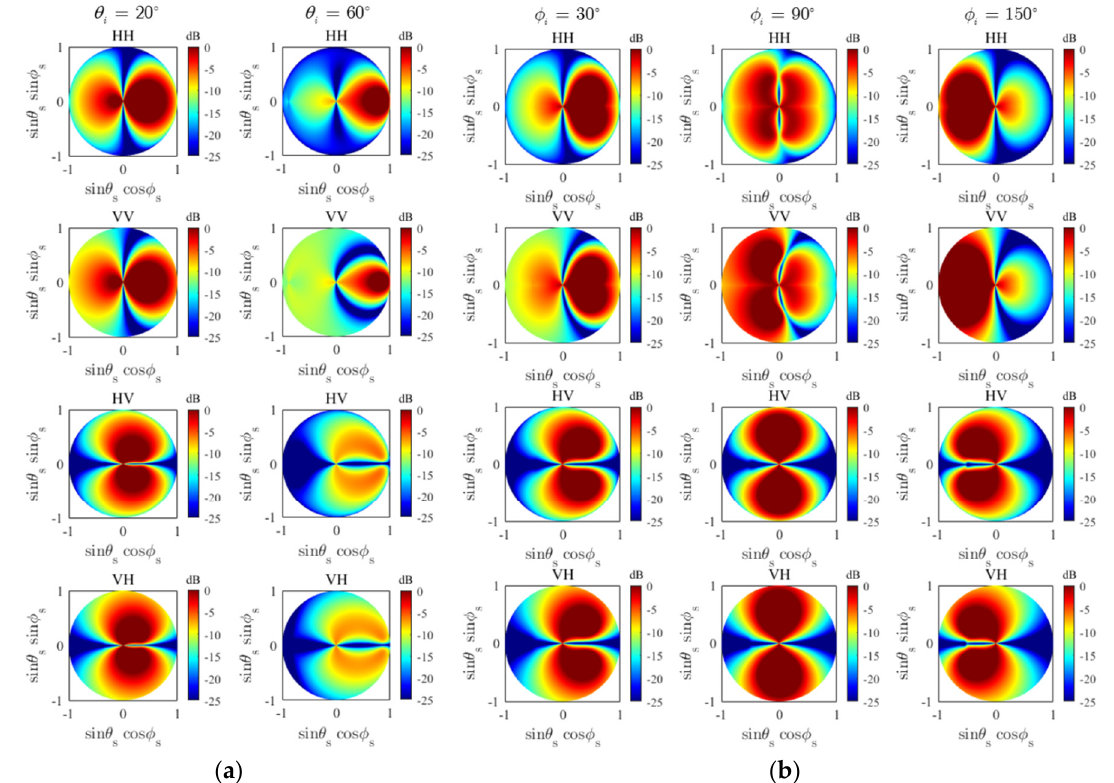
Figure 2. Hemispherical plots of bistatic scattering coefficients σ 0 , σ 0 , σ 0 , σ 0 vv with f = 5.3 GHz, U = 25 m/s, φ w = 30 ◦ : hh hv vh ( a ) φ i = 0 ◦ for all subplots; θ i = 20 ◦ for subplots in the left column and θ i = 60 ◦ for subplots in the right column; ( b ) θ i = 40 ◦ for all subplots; φ i for subplots in the left, middle, and right column are 30 ◦ , 90 ◦ , and 150 ◦ , respectively. Figure 3a shows the hemispherical plot of co-and cross-polarized bistatic scattering coefficients with f = 5.3 GHz, U = 25 m/s, 30 = θ , and , with relative wind direc- i tion varying from up/downwind ( 0 / 180 ) to crosswind ( 90 ). For co-polarization, we see that the strong scattering area in the backward region at up/downwind is more pro- nounced than at crosswind. In addition, the cross-polarization is impacted by the relative wind direction to a lesser extent than co-polarization is. Finally, we examine the sea surface roughness dependence in Figure 3b, which is the hemispherical plot of co-and cross-polarized bistatic scattering coefficients with f = 13.9 GHz, , and , but sea wind speed varying from 7.5 m/s to 19.4 m/s. With the increase of sea wind speeds, sea surface roughness is increased as well. However, the change of scattering coefficients is coupled with three roughness parame- ters. In general, the scattering strength under higher wind speed in both forward and backward regions is greater than the scattering strength under lower wind speed. Espe- cially for cross-polarization under lower wind speed, there is a poorer feature in the back- ward scattering region than that in the forward region.